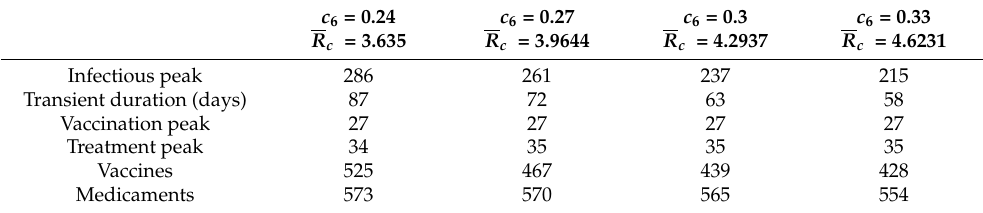
286 261 237 215 87